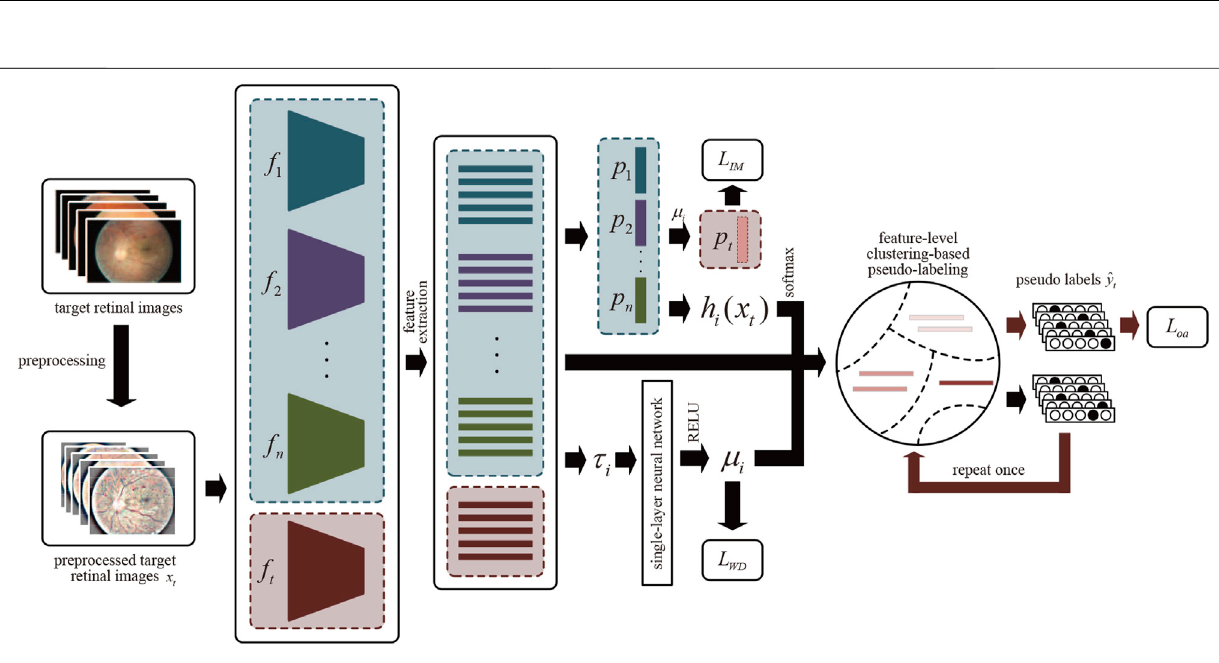
Frontiers in Physiology |